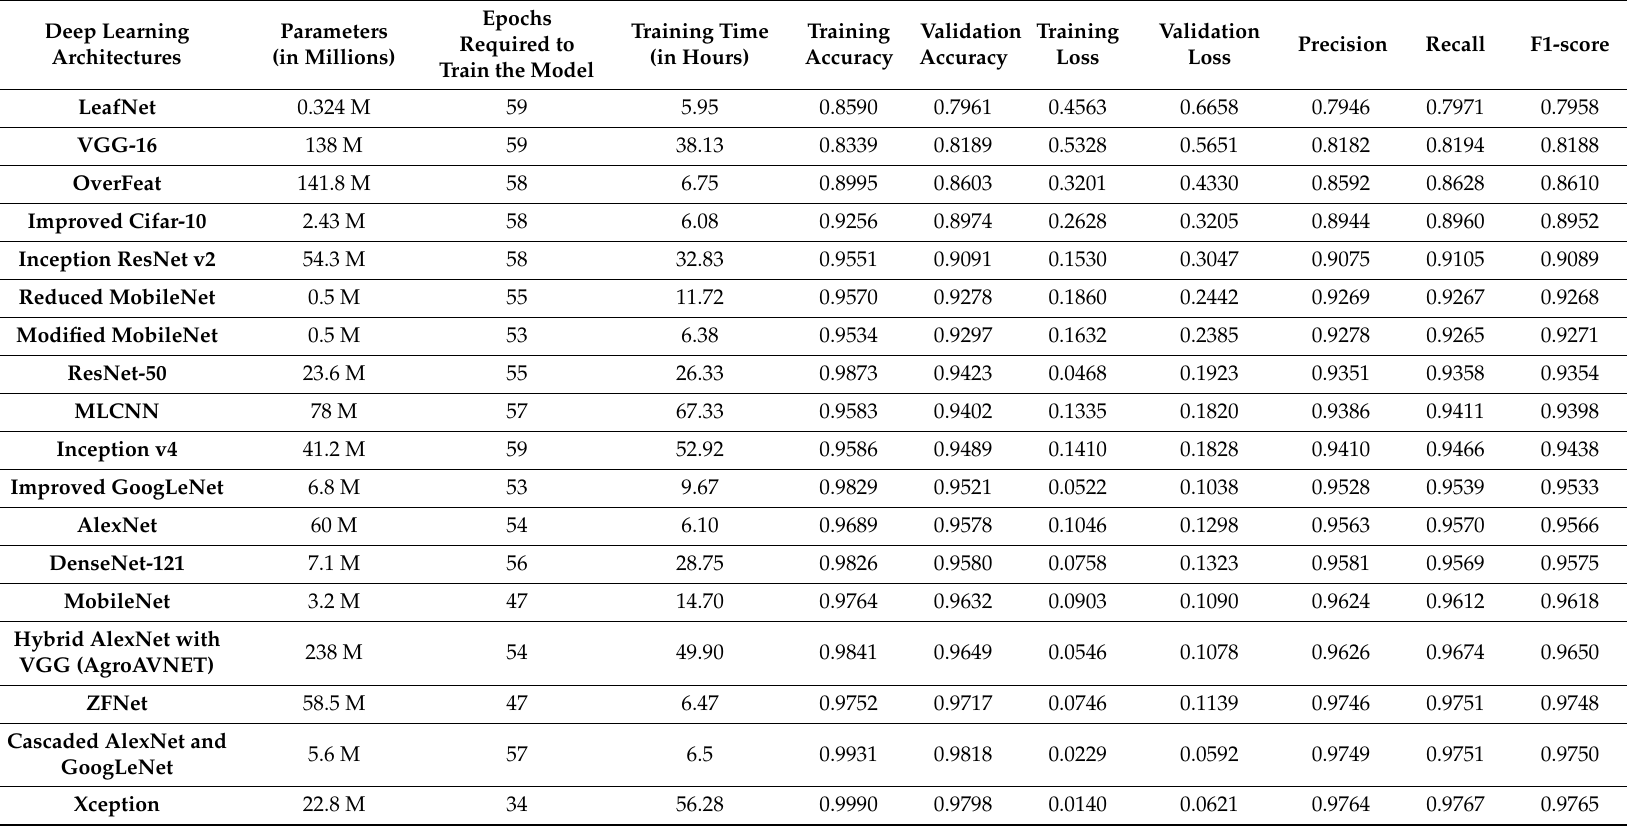
Table 2. Training and validation accuracy / loss, precision, recall, and F1-score along with the number of parameters, training time, and epochs required to train deep learning architectures (in the order of the lowest to the highest